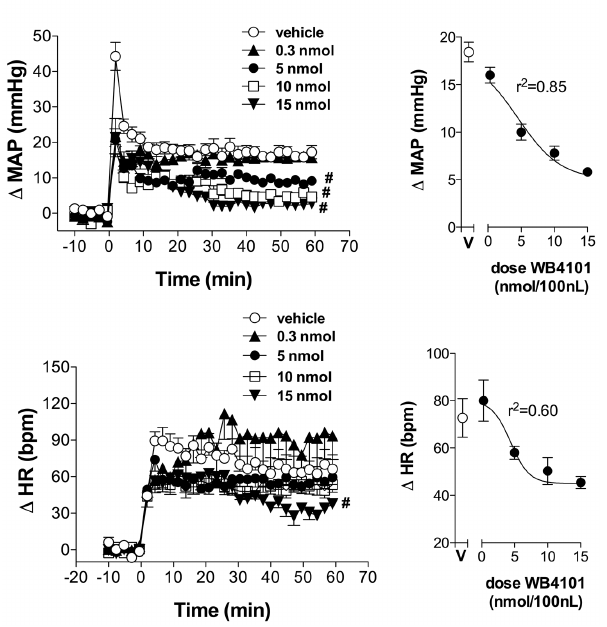
Figure 3. Changes in mean arterial pressure ( D MAP) and heart rate ( D HR) evoked by acute restraint stress in animals treated with different doses of the selective a 1 -adrenoceptor antago- nist WB4101 into the insular cortex. (Left) Time-course of D MAP and D HR during acute restraint stress in rats treated with vehicle (ACSF, 100 nl, n=7) or different doses (0.3, 5, 10 and 15 nmol/100 nl, n=5/ group) of WB4101 into the insular cortex. The onset of exercise was at t=0. Circles represent the mean and bars the S.E.M. # P , 0.05, indicates a significant difference over the whole restraint stress period compared to vehicle treated animals; ANOVA followed by Bonferroni’s post test. (Right) D MAP and D HR during acute restraint stress in rats treated with increasing doses of WB4101 (0.3, 5, 10 and 15 nmol/100 nl). V: vehicle (ACSF, 100 nl). Dose–effect curves were generated by nonlinear regression analysis. Data shown represent the means 6 S.E.M. of the variation of MAP and HR during the 60 min of restraint. # P , 0.05, significantly different from vehicle group; one-way ANOVA followed by Bonferroni’s post test.